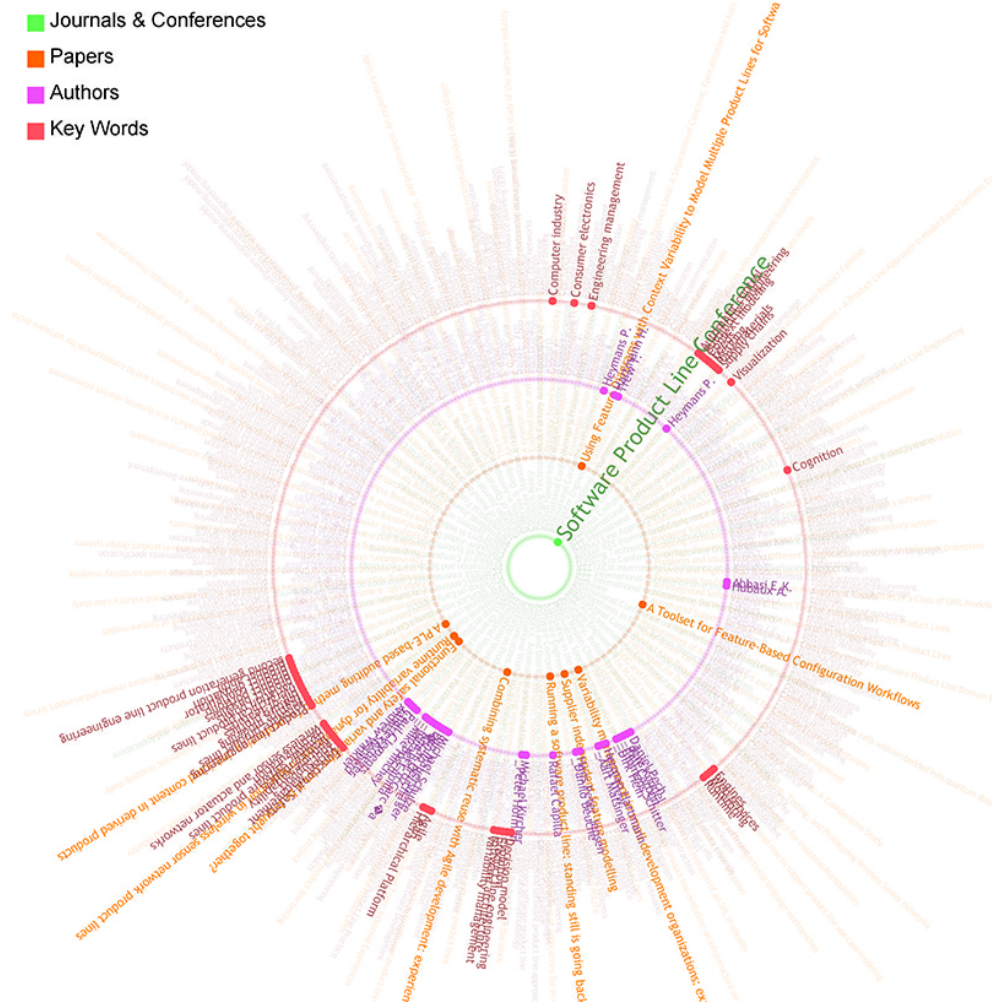
Figure 6. Overview step when a journal has been